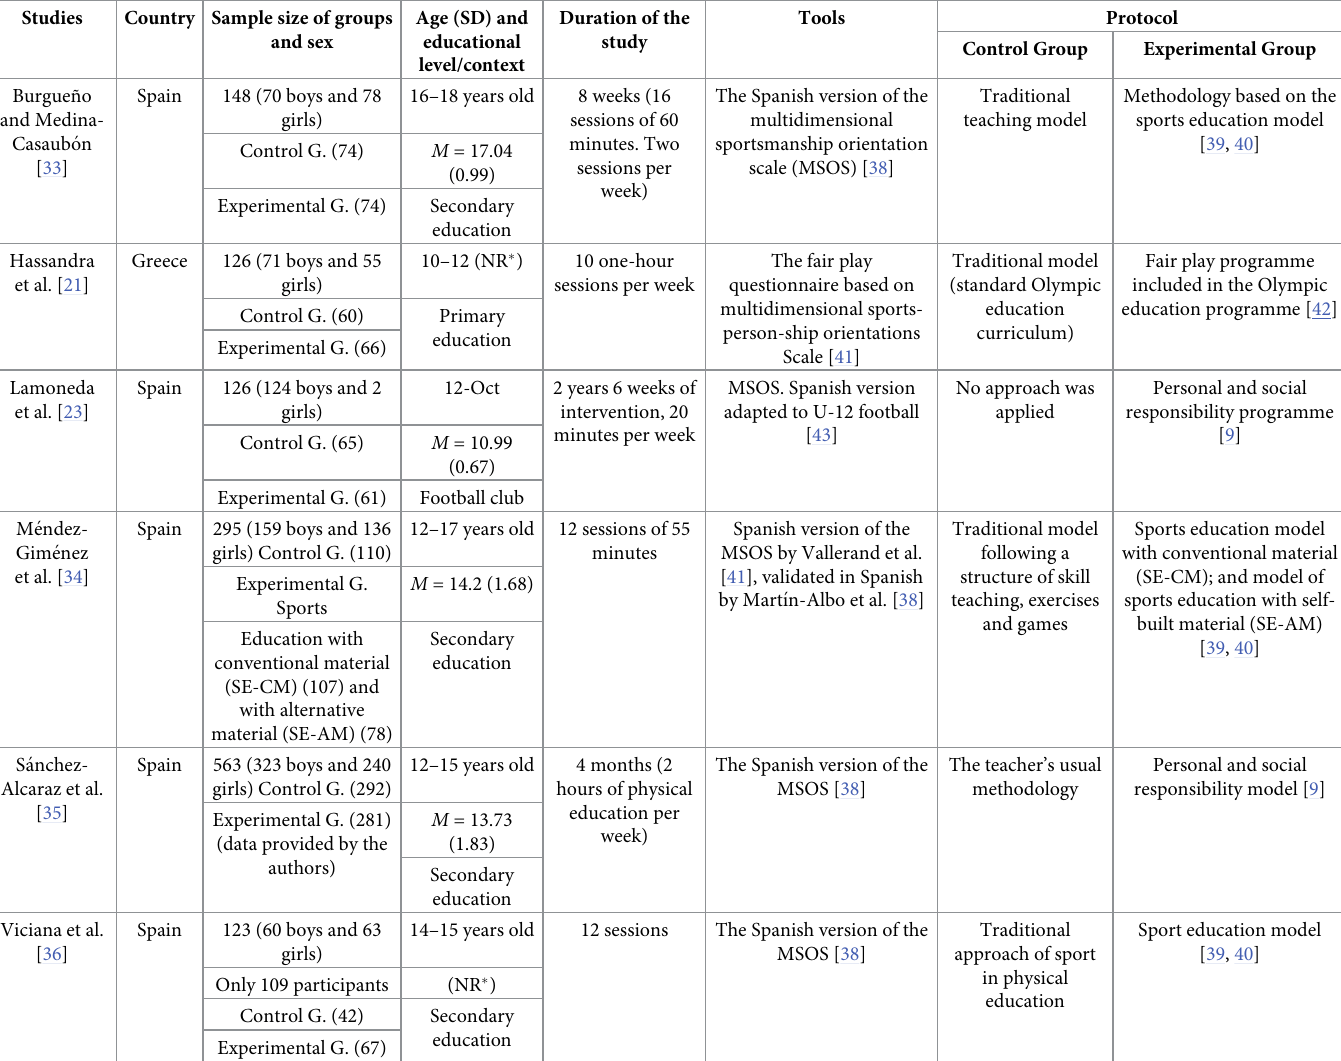
Table 2. Characteristics of the participants, duration, instrument and protocol of the interventions included in the systematic review and meta-analysis.